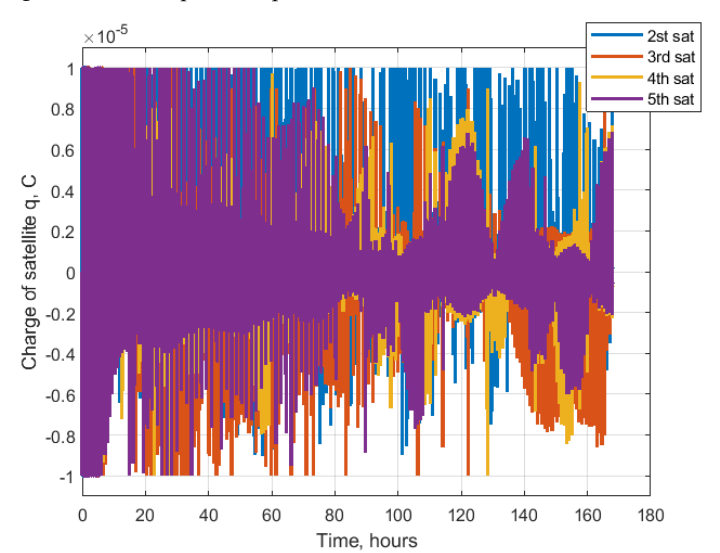
Figure 35. Out-of-plane amplitude.